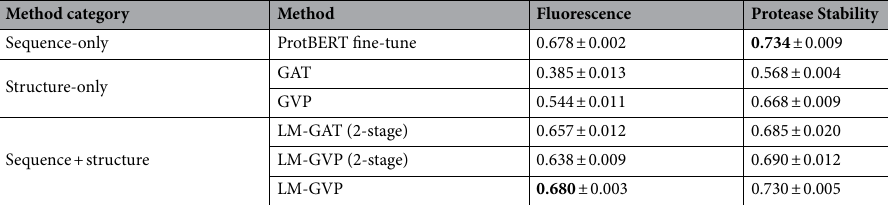
Table 2. Performance of LM-GVP and other baseline models in TAPE protein engineering tasks. Spearman’s correlation coefficients calculated from hold-out test sets are shown in the table to evaluate the predictive